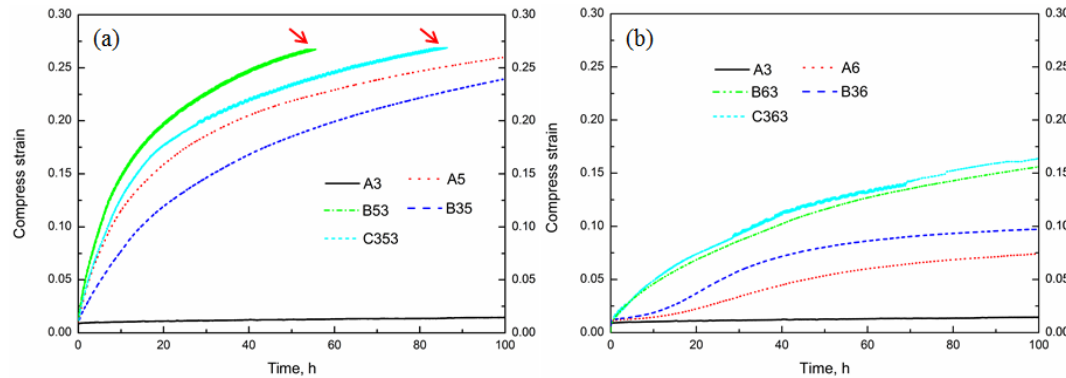
Figure 7. Creep curves after various heat treatments involved at 500 °C ( a ) and 625 °C ( b ).